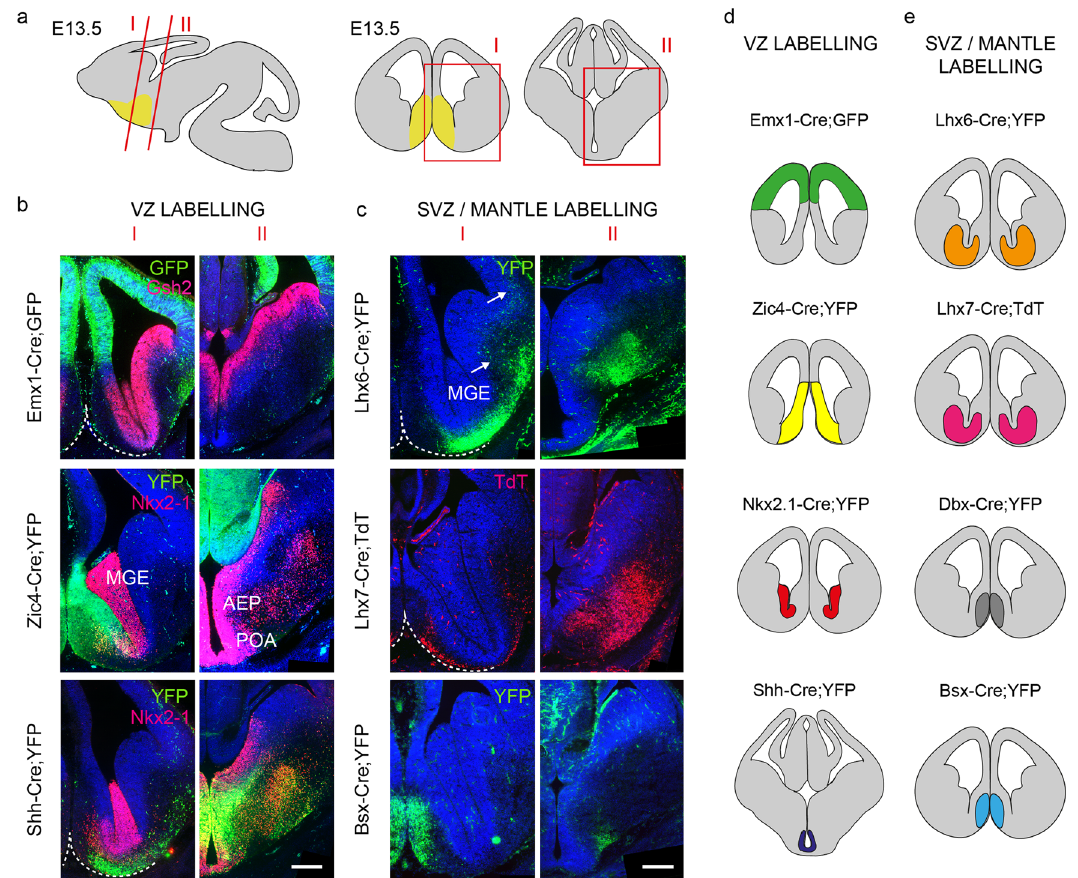
Fig. 2 Transgenic mice used to fate-map the embryonic septum. a Schematic representation of a sagittal E13.5 mouse brain section and the corresponding coronal cuts shown in I and II. Boxed areas in red are shown for rostral (I) and caudal (II) levels. The position of the septum is indicated in yellow. b YFP/ GFP expression in forebrain germinal regions (ventricular zone, VZ) of three lines used for fate mapping. Cre recombination can be detected in the neocortex (Emx1-Cre;GFP), the septum (Zic4-Cre;YFP) and the AEP/POA (Shh-Cre;YFP). Immunolabelling for Gsh2 and Nkx-2-1 delineates the subpallium and the MGE/POA regions, respectively. Scale bar: 200 μ m. c Transgenic lines with expression in the subventricular (SVZ) and mantle zones. In Lhx6- Cre;YFP, YFP labelling spans the MGE SVZ and mantle. YFP + ve neurons initiating their migration toward the cortex are indicated with white arrows. TdT expression is detected in presumptive immature cholinergic forebrain neurons in Lhx7-Cre;TdT. YFP immunoreactivity can be detected in the mantle zone of the septum in Bsx-Cre;YFP mice. Ventral boundaries are indicated by a dashed white line. AEP anterior entopeduncular region, MGE medial ganglionic eminence, POA preoptic area. Scale bar: 200 μ m. d , e Summary of VZ- and SVZ/mantle-expressing Cre lines used in this study. The area of expression for each transgenic line is identi fi ed by a different colour. The same colour coding is used in subsequent fate-mapping Figs. 3 –